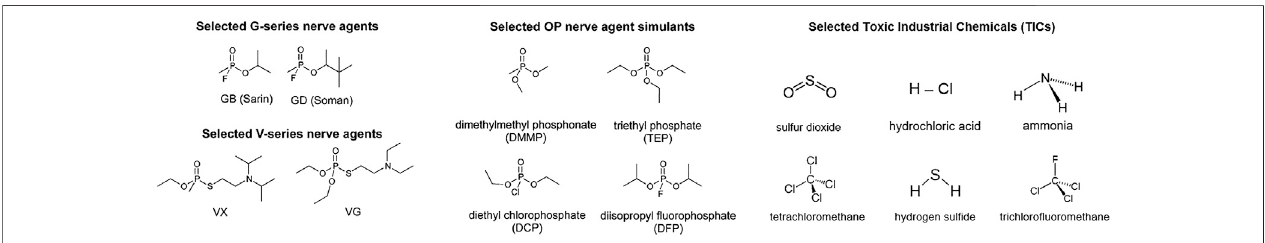
FIGURE 1 | Molecular structure of common CW agents, CW simulants, and TICs. Adapted from Dennison et al. (2014) with permission from the Royal Society of Chemistry.